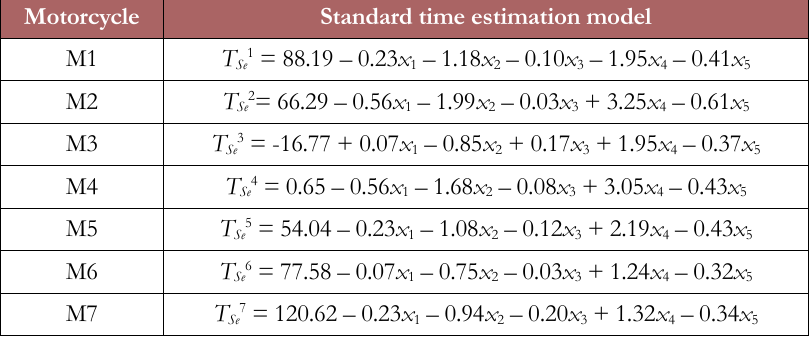
Table 8. Multiple linear regression models for the rear of motorcycles